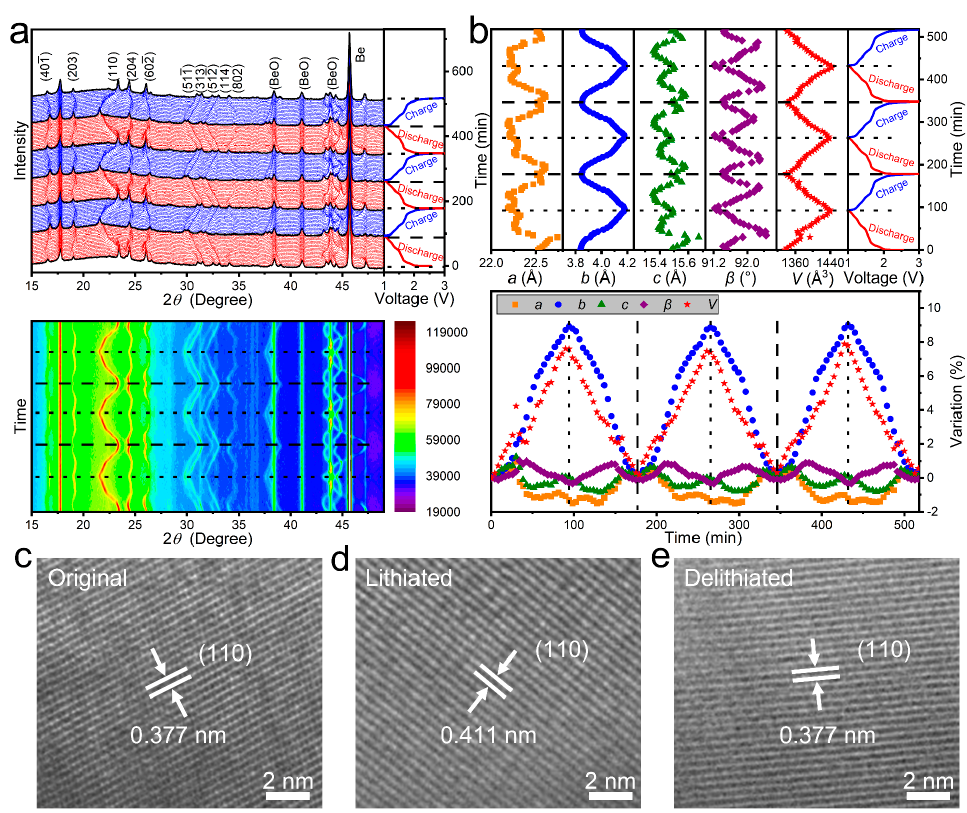
Figure 4. Crystal structure evolutions of C-CuNb 13 O 33 . ( a ) Original in-situ XRD patterns with GCD profiles (0.4C) and contour in-situ XRD patterns of C-CuNb 13 O 33 /Li in-situ cell (first three cycles). ( b ) Lattice-parameter variations of C-CuNb 13 O 33 (initial three cycles). Ex-situ HRTEM characteriza- tion of ( c ) original, ( d ) lithiated (1.0 V), and ( e ) delithiated (3.0 V) C-CuNb 13 O 33 samples.